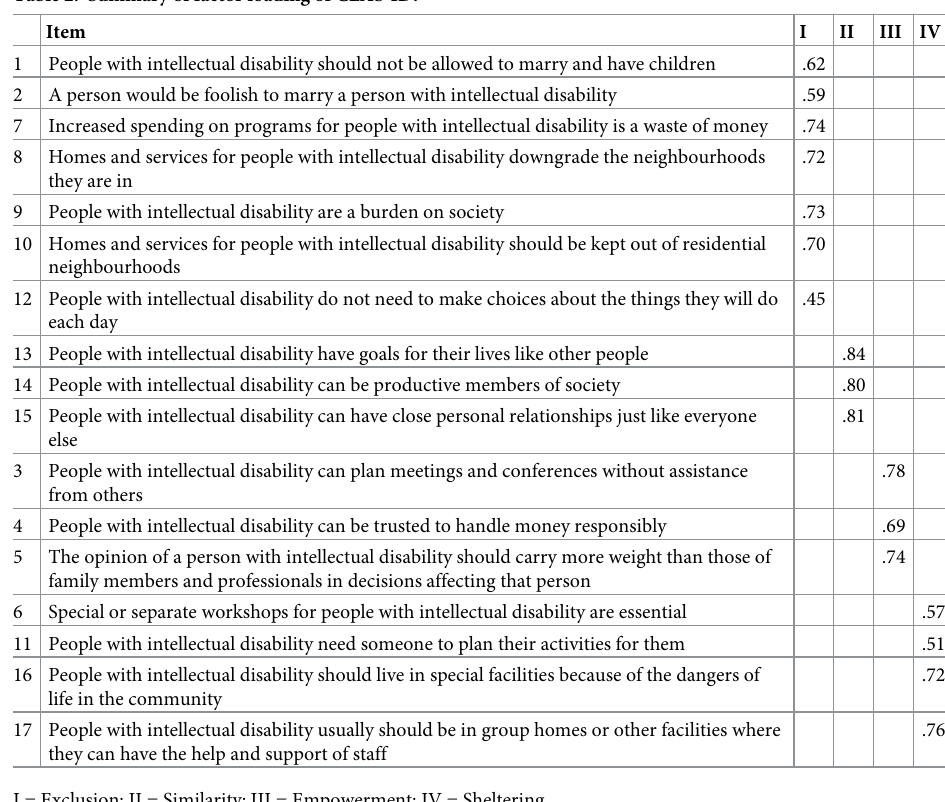
Table 2. Summary of factor loading of